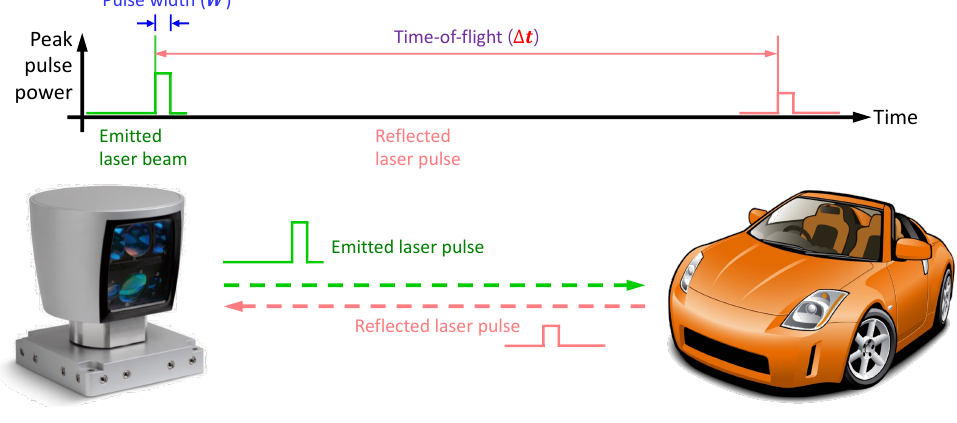
Figure 2. The working principle of a LIDAR